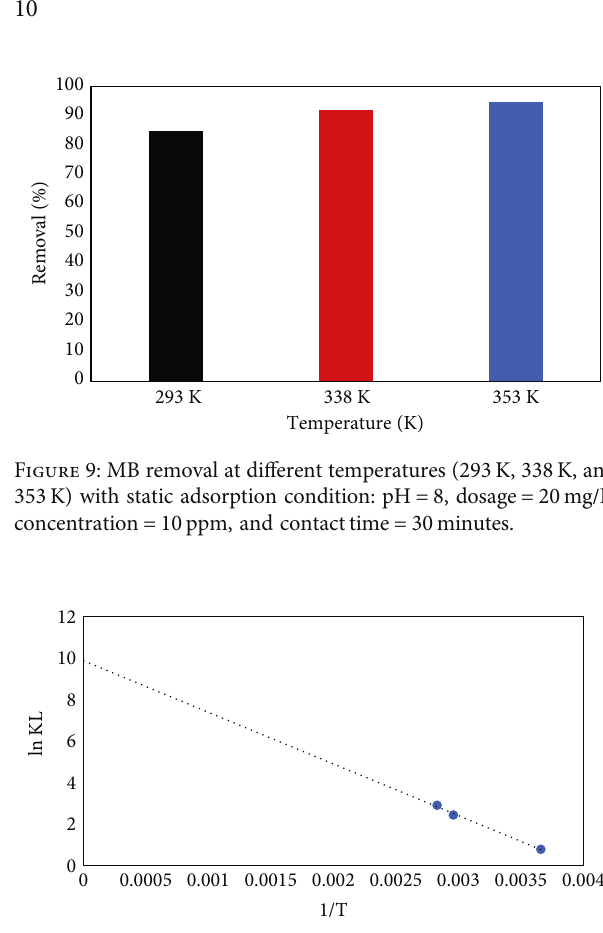
Figure 10: Van ’ t Ho ff plot for evaluating the thermodynamic parameters of MB adsorption by GO functionalized CA with 1% p -SOCX. Static adsorption condition: pH8, dosage 20mg/L, concentration 10ppm, and contact time 30 minutes. Table 2: Thermodynamic parameters for MB adsorption onto GO functionalized CA with 1% p -SOCX.